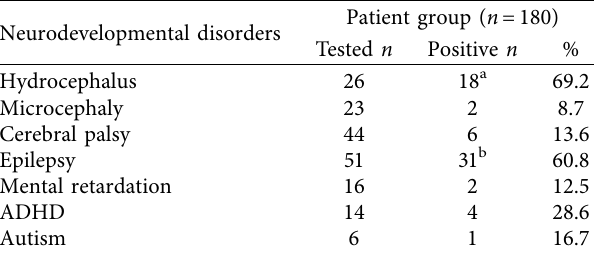
Table 3: Seropositivity of T. gondii infection in relation to the neurodevelopmental disorders in the patient group.